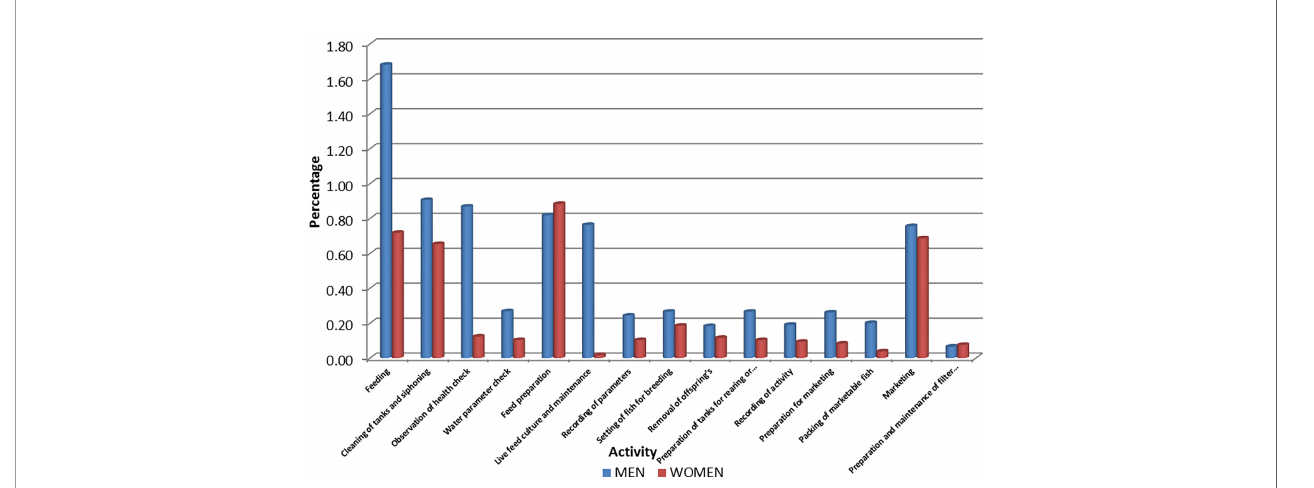
FIGURE 3 | Activity pro fi le (time spent) of men and women on productive